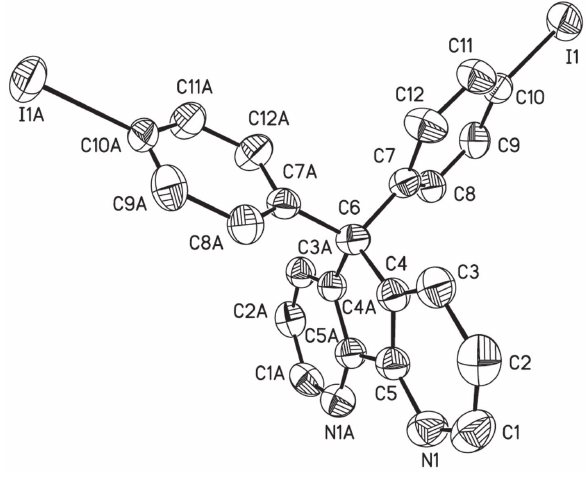
Table 1: Data collection and handling.